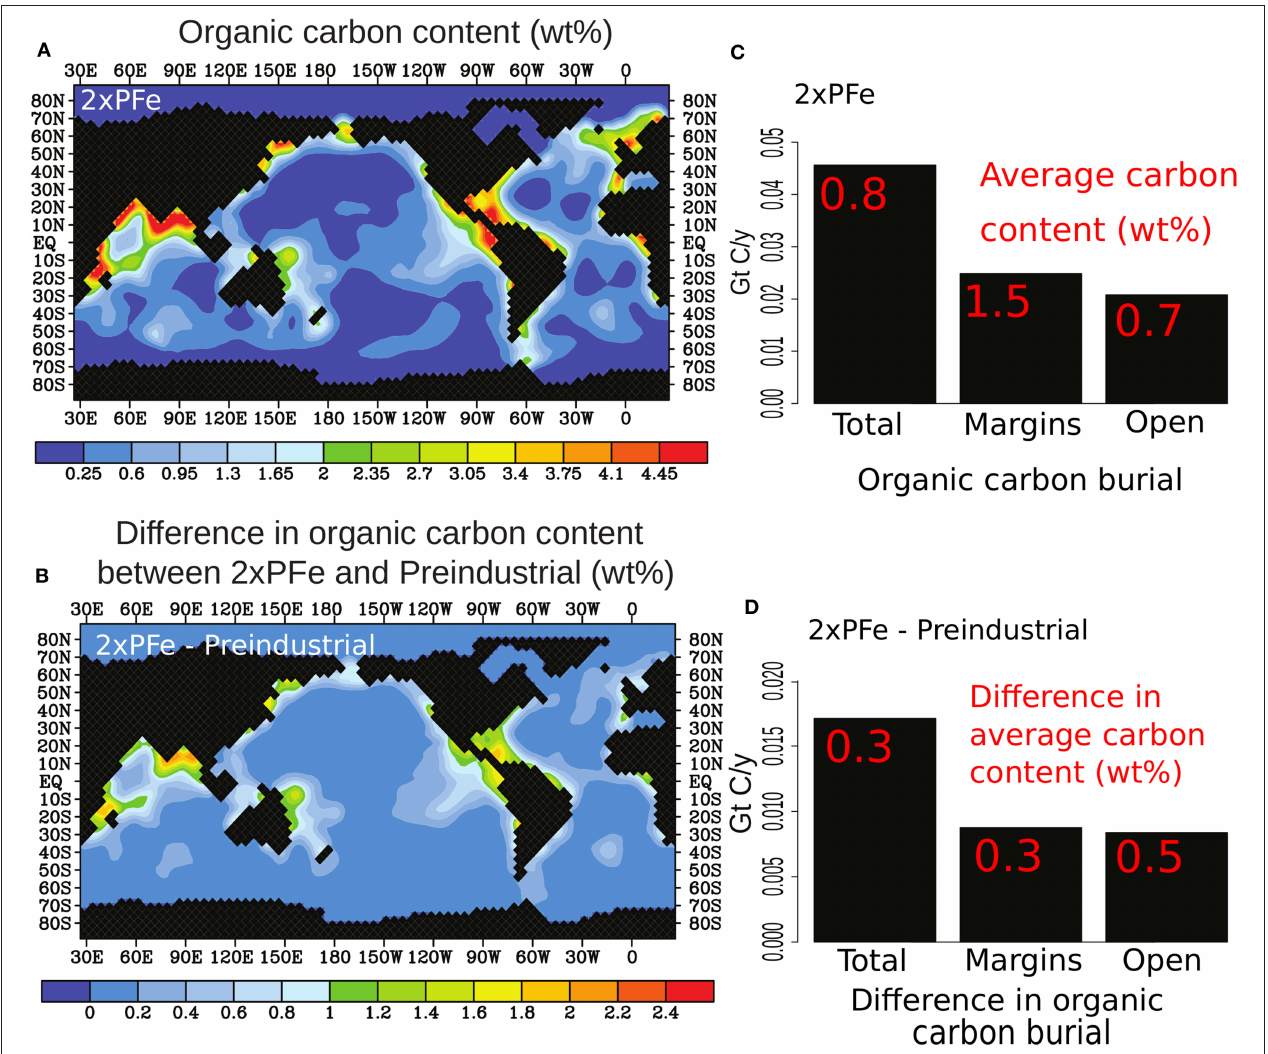
FIGURE 2 | (A) Organic carbon content averaged over the sediment layer in the model (10 cm) in the scenario with a doubling of riverine phosphorus and iron dust inputs (2xPFe), (B) difference in the organic carbon content in the 2xPFe scenario relative to the Preindustrial scenario, (C) rate of burial of organic carbon and (in red) average organic carbon content of sediments in the total ocean, on the margins and in the open ocean for the 2xPFe scenario and (D) the differences when compared to pre-industrial values. Results are shown for the run after 200